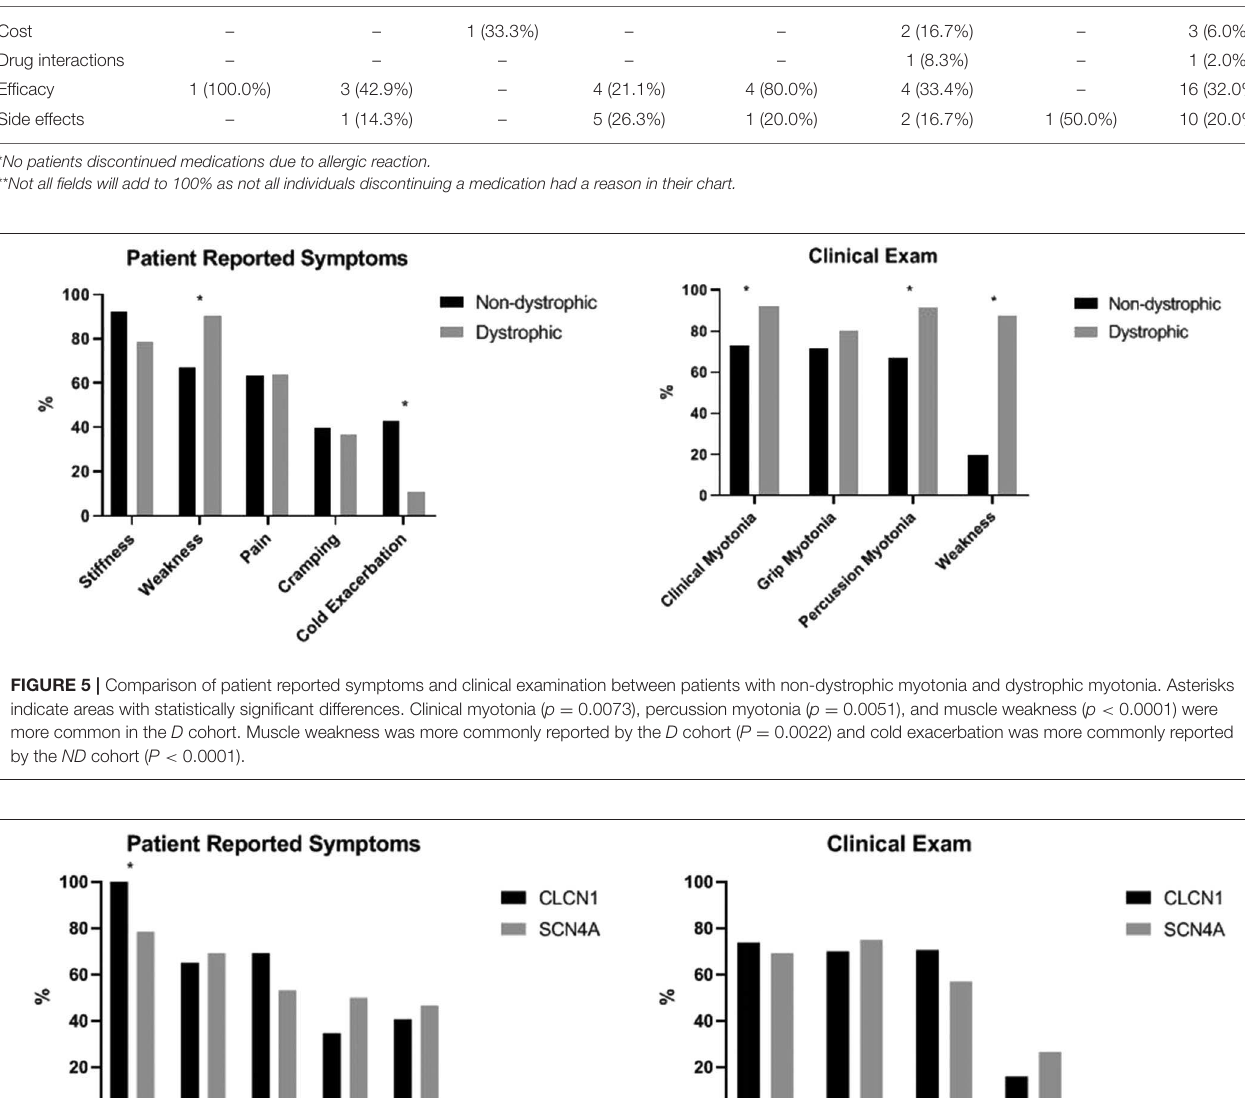
TABLE 7 | Summary of reasons patients discontinued commonly utilized antimyotonia agents. Reason